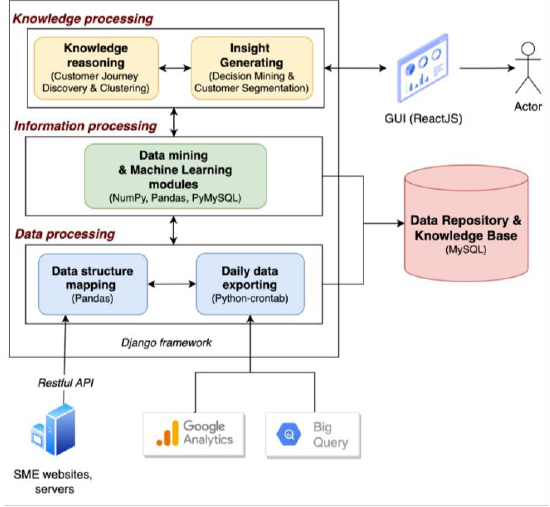
Fig. 3. Customer journey management